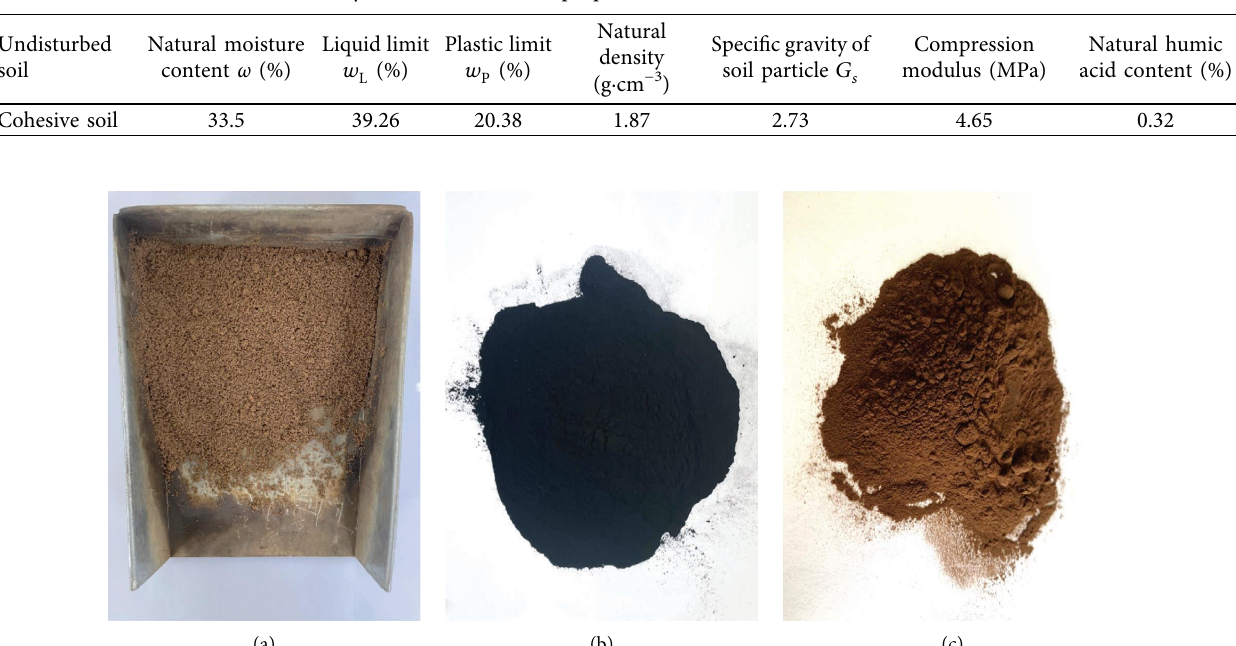
Figure 1: Test material: (a) undistributed soil; (b) humic acid reagent; (c) fulvic acid